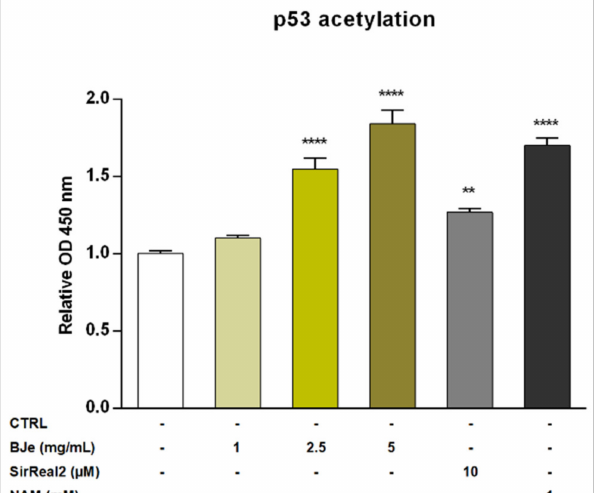
Figure 7. Acetylation of p53 in THP-1 cells after treatment with BJe for 24 h. Control (CTRL, white bar) consists in untreated cells, while BJe (yellow bars) was assessed at the concentrations shown in the figure. Specific and non-specific SIRT2 inhibitors, SirReal2 (grey bar) and NAM (black bar), were used as positive controls. Relative protein levels of acetylated p53 were quantified by ELISA. Data are expressed as fold change relative to controls (untreated cells) and represent the mean ± SEM of three independent experiments performed in triplicate ( n = 9). ** p < 0.01 and **** p < 0.0001 vs.